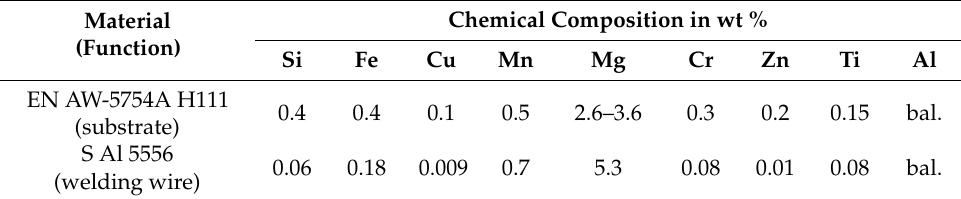
Table 1. Chemical composition of the substrate and the welding wire (wt %).